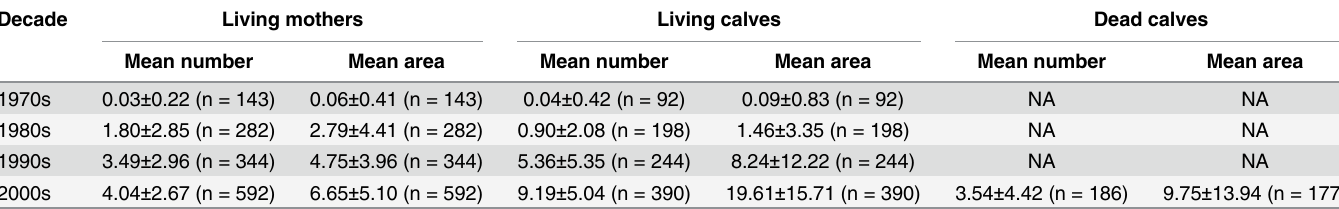
Table 3. Wounding of living mothers, living calves and dead calves by decade (1970s-2000s).